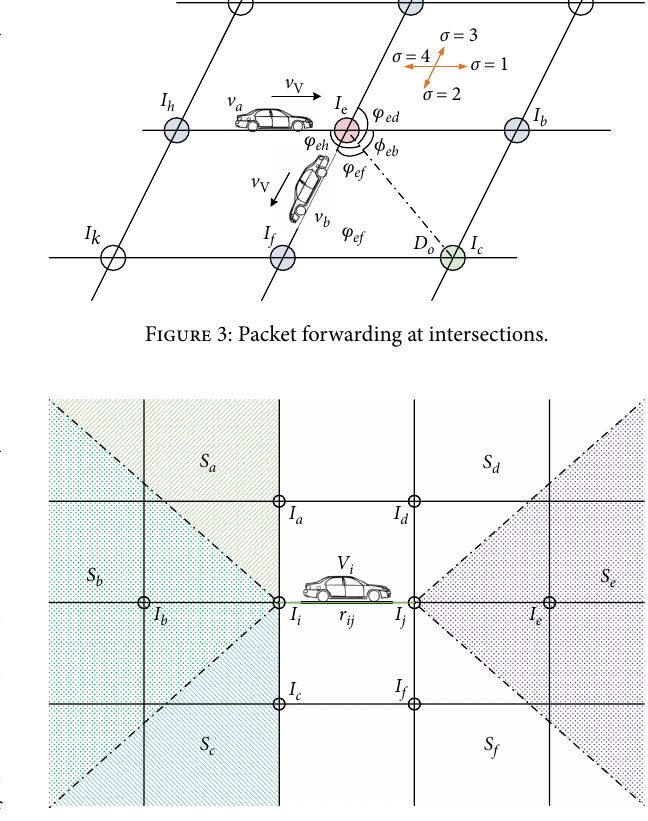
Figure 4: Illustration of the optimal